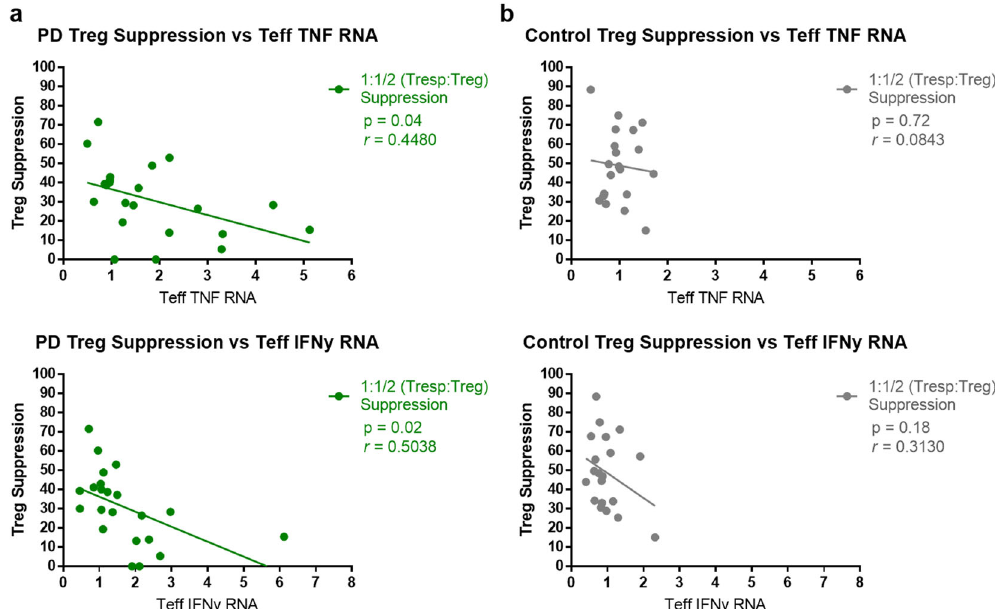
Fig. 4 Analysis of Treg suppression and pro-in fl ammatory Teff transcripts. a A decrease in PD Treg suppression correlates with an increase in Teff-derived pro-in fl ammatory TNF transcripts. r = 0.4480 and p = 0.04 for PD Teff TNF transcripts against 1:1/2 (Tresp:Treg) ratio suppression assay. An increase in Teff IFN γ transcripts is correlated with declines in corresponding patient Treg suppression. r = 0.5038 and p = 0.02 for PD Teff IFN γ transcripts against 1:1/2 ratio (Tresp:Treg) suppression assay. b No signi fi cant correlation was seen between control Treg suppression and their corresponding Teff pro-in fl ammatory